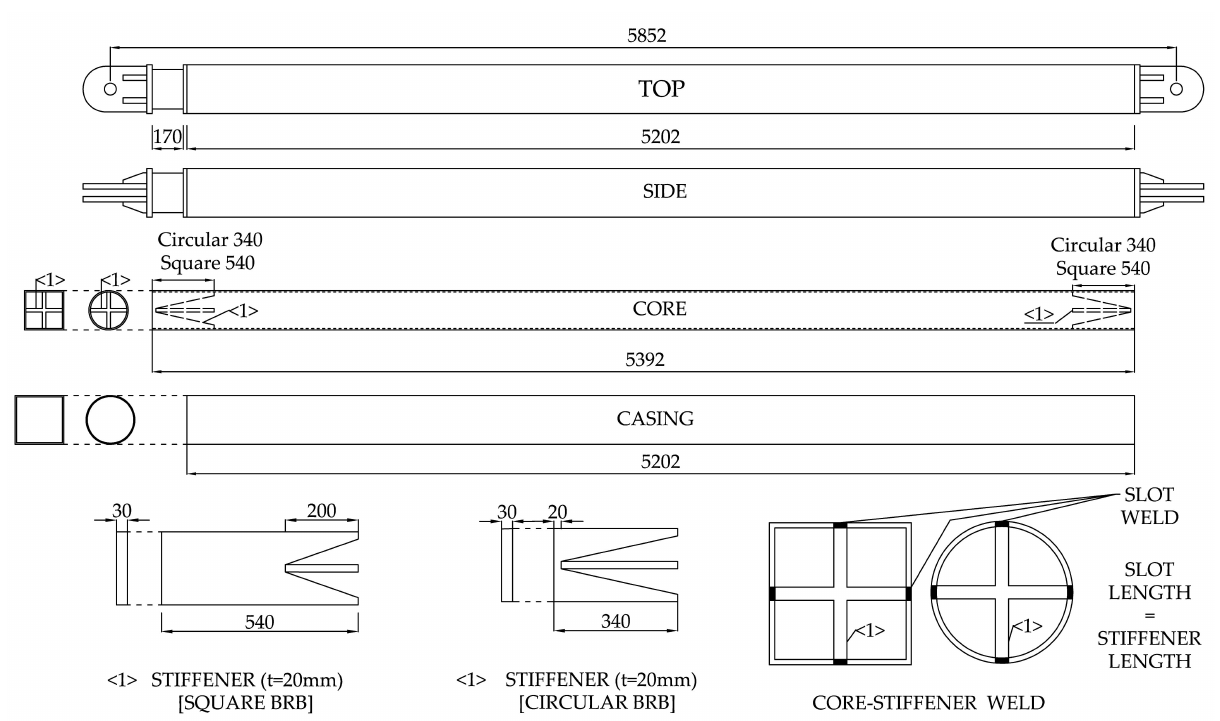
Figure 2. Details of the proposed BRB. (All dimensions are in